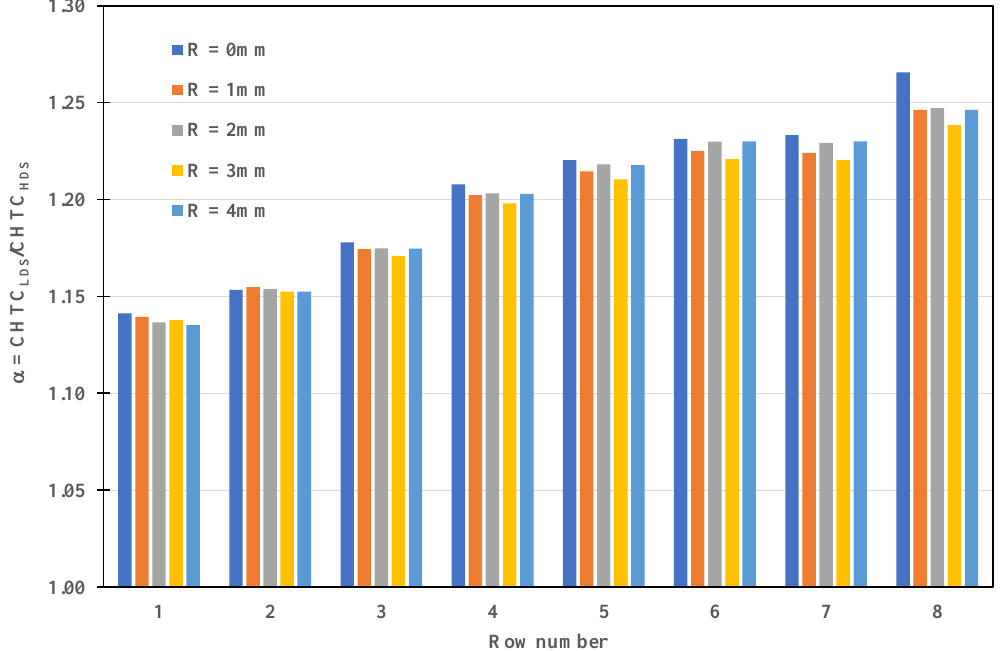
Figure 9. The ratios (α = CHTC LDS /CHTC HDS ) for different kiln boundary roughness levels.